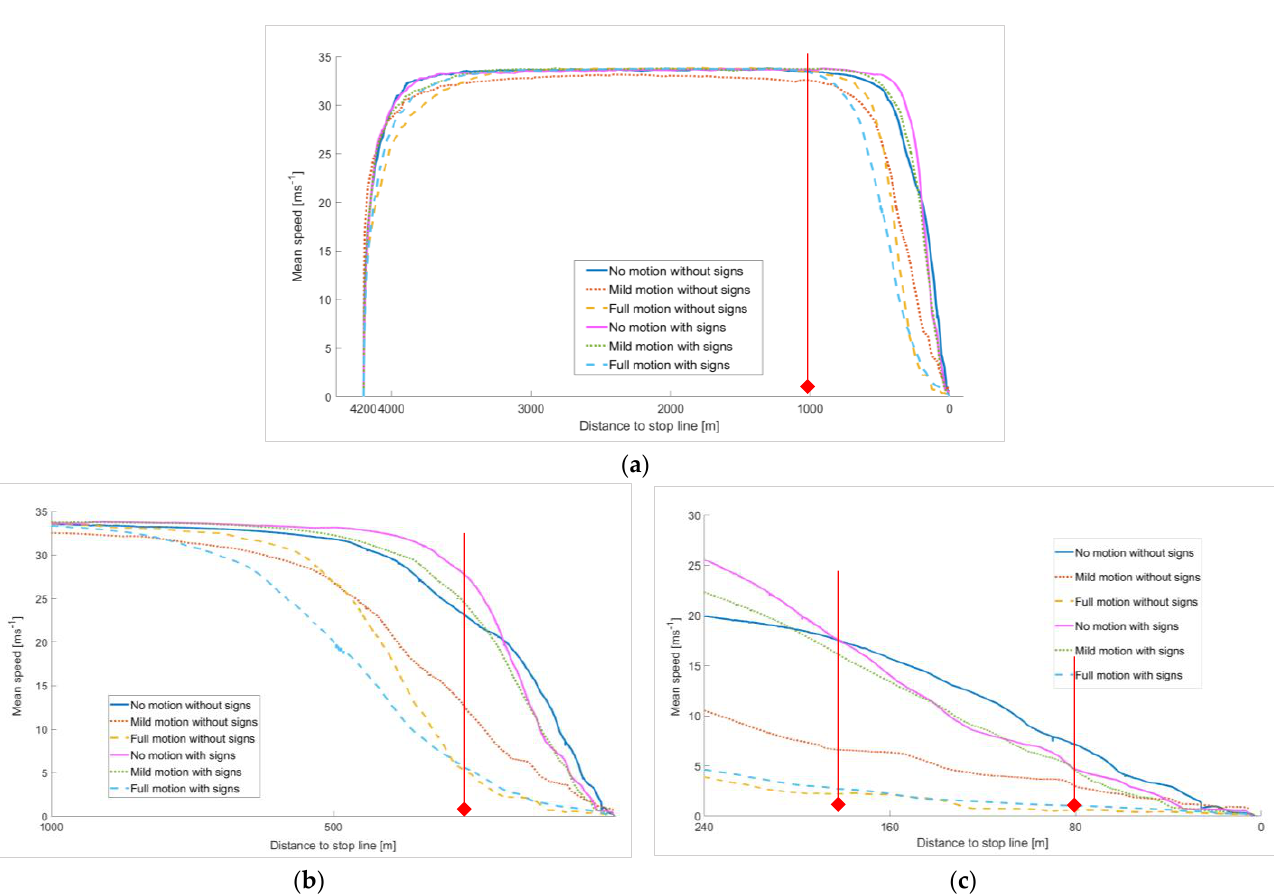
Figure 7. Mean speed profiles at various distances from the stop line: ( a ) 4200 m before Stop line, ( b ) 1000 m before Stop line and ( c ) 240 before Stop line. The vertical lines in red were inserted as reference points to indicate a significant change in speed behavior in the same area.